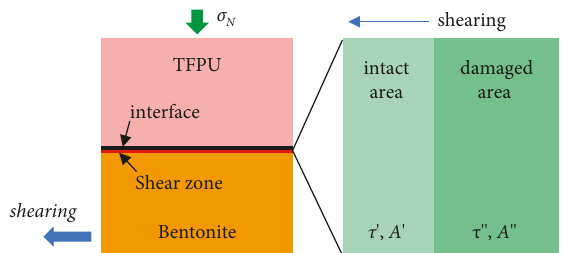
Figure 4: Schematic diagram of the development of the shear damage of the TFPU-bentonite contact